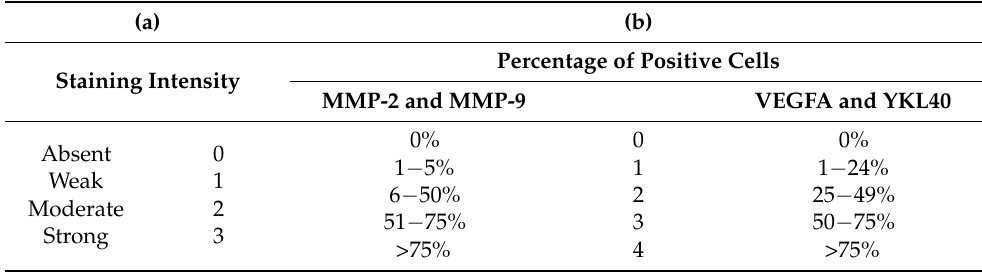
Table 1. Classification of the intensity of the IHC staining ( a ) and the proportion of positive cells ( b ).